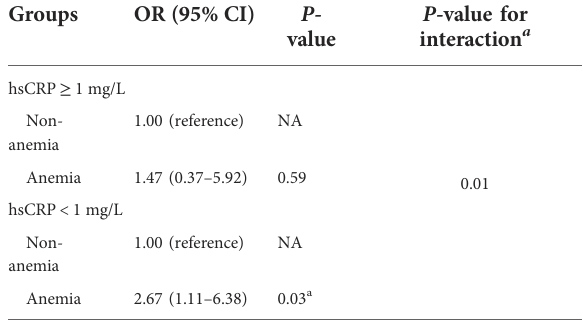
TABLE 3 Risk of anemia-associated AKI according to hsCRP threshold.